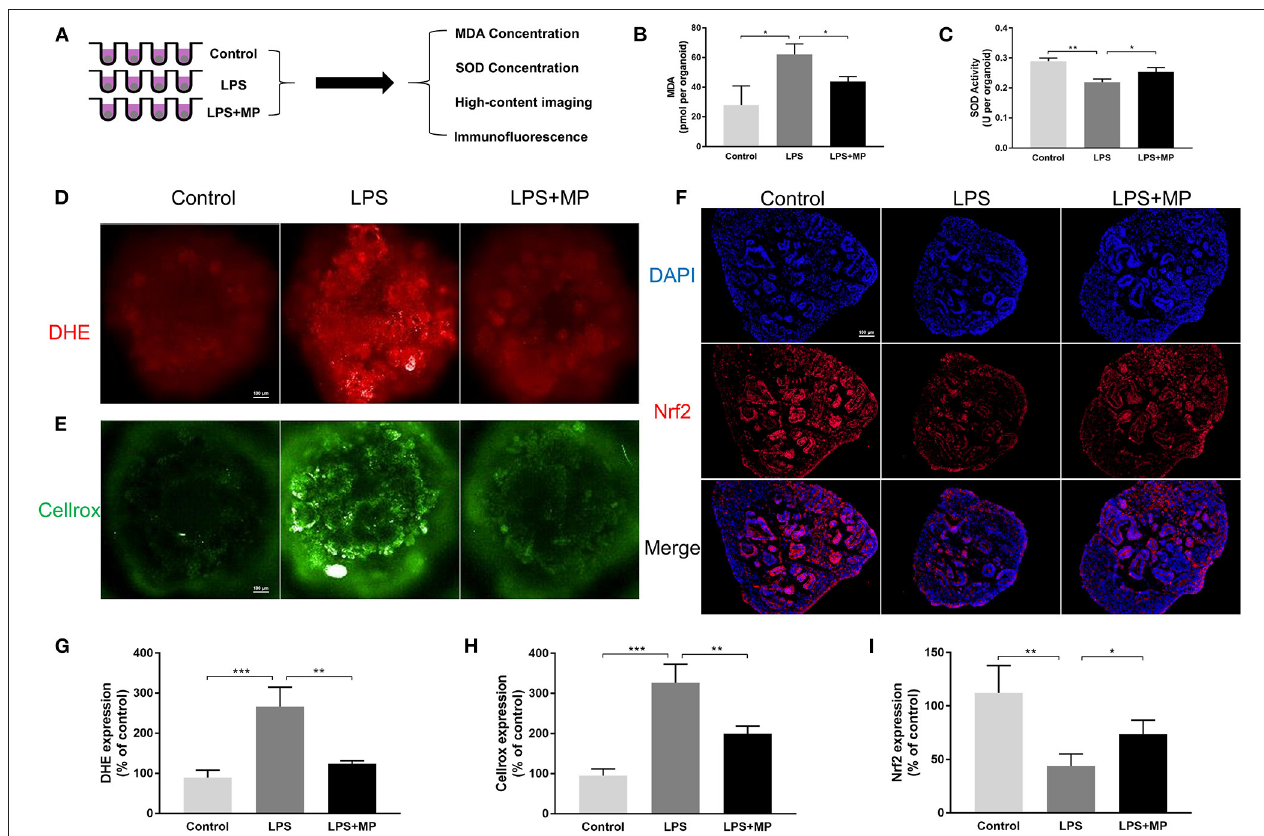
FIGURE 5 | LPS enhances oxidative stress in kidney organoids and is alleviated by MP. (A) Schematic representation of the study design of oxidative stress evaluation in kidney organoids. (B) malondialdehyde (MDA) concentration of kidney organoids treated with LPS and MP. (C) superoxide dismutase (SOD) activity of kidney organoids treated with LPS and MP. (D) dihydroethidium (DHE) and (E) Cellrox staining of live kidney organoids under high-content imaging analysis. (F) Expression pattern of Nrf2 (Red) in the control, LPS, and LPS + MP treatment group. The corresponding semi-quantitative analysis of (G) DHE (H) Cellrox and (I) Nrf2. Scar bar = 100 µ m. * P < 0.05, ** P < 0.01, *** P <